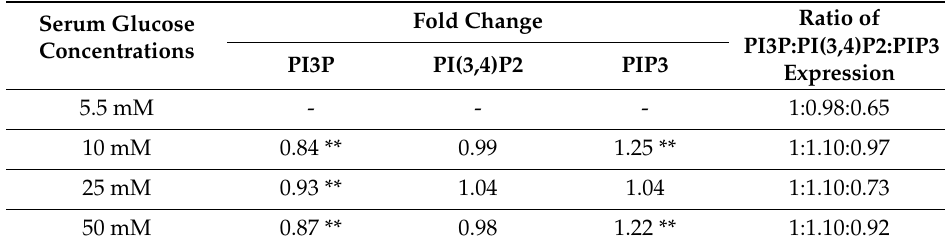
Figure 8. Effect of glucose concentration on PI3P, PI(3,4)P2, and PIP3 concentration across SKBR3 cell line (fluorescence intensity in fixed cells, n > 60). The % of total PI lipid for each mono-, di-, and tri-phosphorylated PI was determined through intensity analysis for the SKBR3 cell line, incubated at 5.5 ( (cid:3) ), 10 ( (cid:3) ), 25 ( (cid:3) ), and 50 ( (cid:3) ) mM serum glucose concentrations, respectively. * denotes p < 0.05 and ** denotes p < 0.005 as determined by a one-way ANOVA pair-wise comparison. Table 5. Analysis of SKBR3 cell surface lipidome.